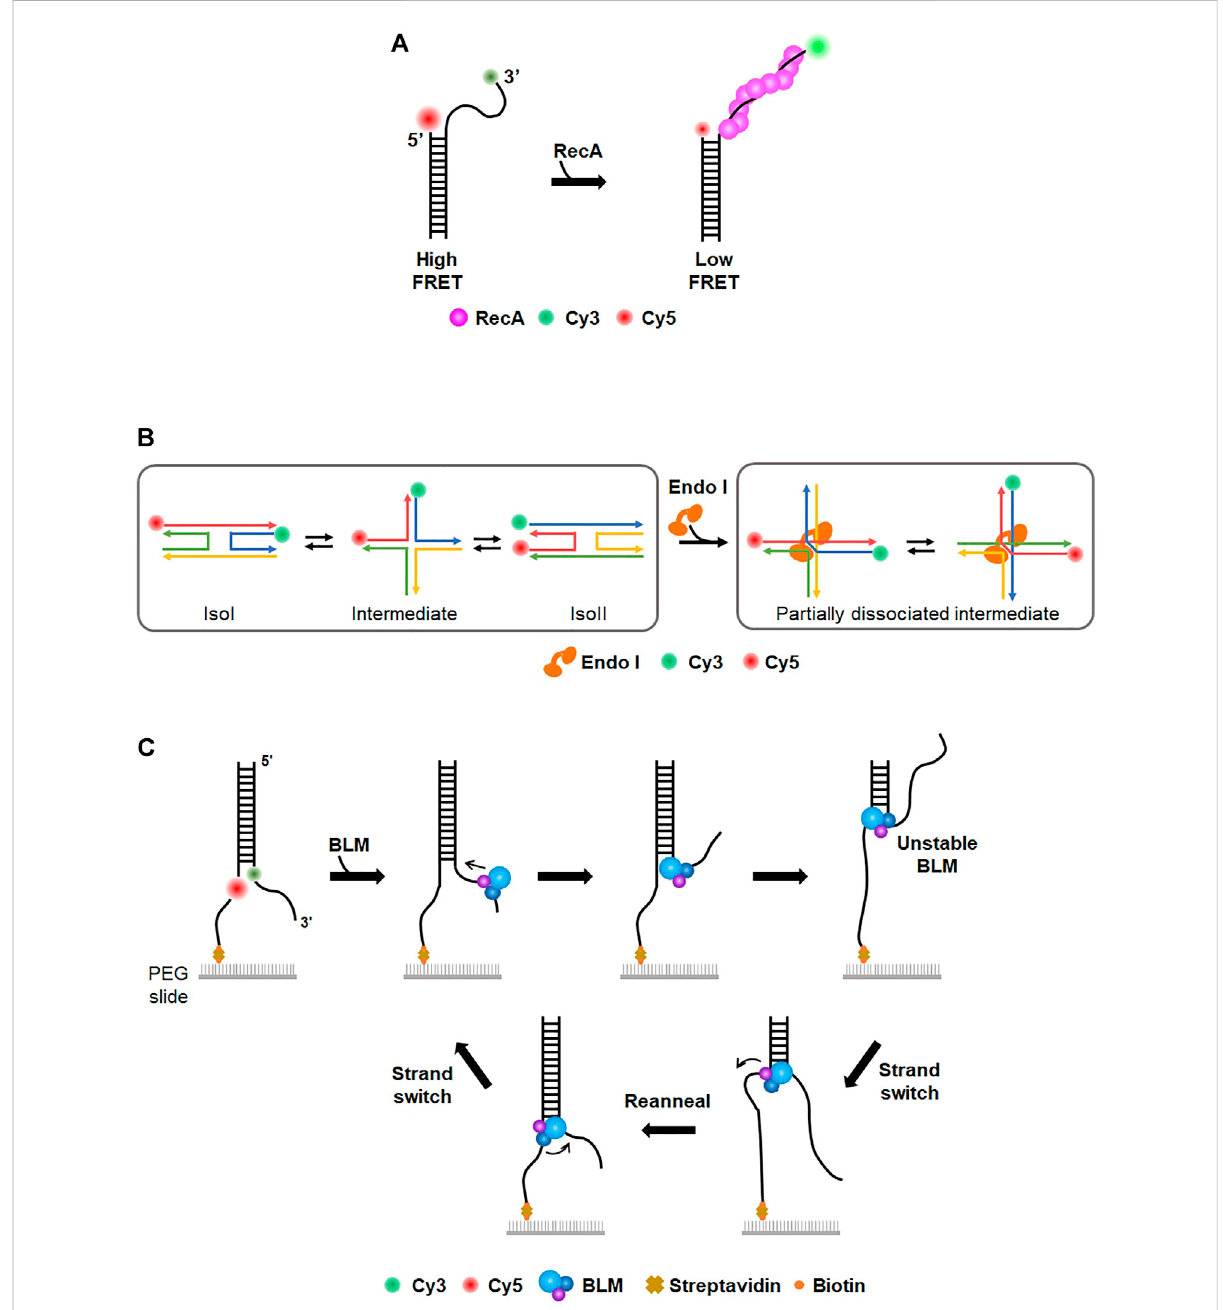
FIGURE 3 Single-molecule FRET (smFRET). (A) Study of RecA fi lament formation using smFRET. Donor (Cy3) and acceptor (Cy5) dyes are labeled at the 3 ′ end of the ssDNA overhang and junction, respectively. In the absence of RecA, the fl exibility of ssDNA overhang allows high FRET. The addition of RecA forms anucleoprotein fi lament on ssDNA, which extends ssDNA and induces low FRET. (B) Conformational dynamics ofHollidayjunction (HJ) and the effect of HJ-resolving enzymes (Endo I). (Left) The four-way junction has two conformers (isoI and isoII) that can be distinguished by low and high FRET ef fi ciency, respectively. The conformational dynamics of HJ are characterized by smFRET (Right) HJ-resolving enzyme (e.g., EndoI). induces apartially dissociated intermediate, which is evolutionarily conserved. (C) Donor (Cy3) and acceptor(Cy5) dyes are internally labeled atthejunctionoftheforkstructuretoallowhighFRET.BLMhelicasetranslocatesfromthe3 ′ to5 ′ endandunwindsdsDNA,loweringFRETef fi ciency. After BLM separates a certain length of duplex DNA, BLM transfers to the other strand and reanneals the duplex. This strand switching happens